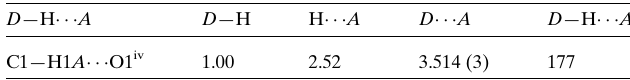
Table 2 Experimental details. Crystal data Chemical